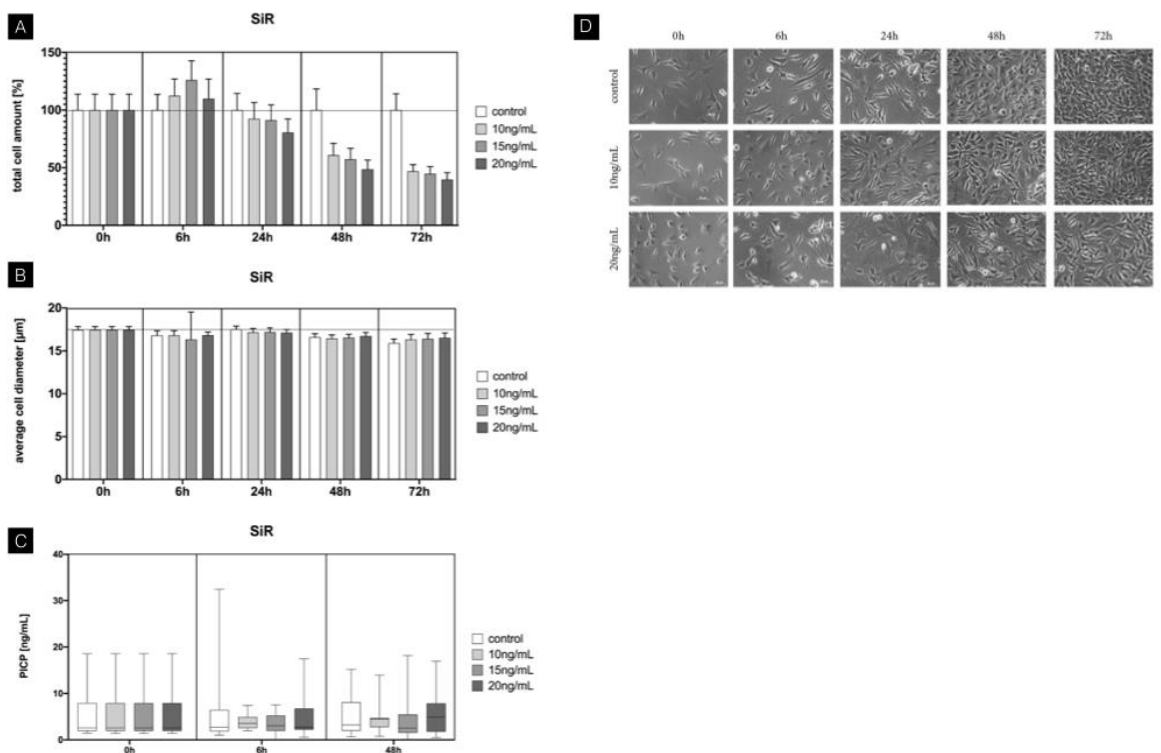
Figure 4. Time-dependent influence of sirolimus on mouse fibroblasts. ( A ) Total cell amount (baseline-corrected). Constant downregulation after 24 h along with increased concentrations. Drop in total cell amount after 72 h independent of concentration. ( B ) Average cell diameter showing no significant influence of SiR. ( C ) Procollagen concentration with no significant changes using different concentrations of SiR. ( D ) Cell morphology evaluation using light microscopy between 6 h and 72 h. Overall increased cell confluence with longer incubation periods. Reduced cell confluence within the same period showing concentration-dependent effects of SiR. Columns and error bars represent the mean ± SEM (n = 12); significant ( p < 0.05).